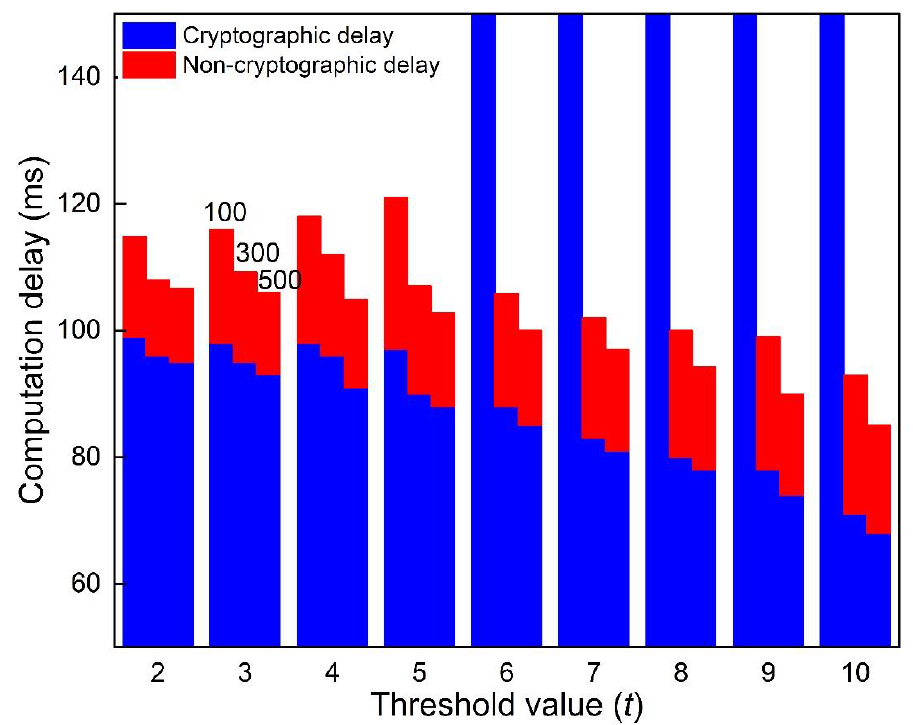
Figure 8. A comparison of cryptographic delay and non-cryptographic delay at various threshold values and number of vehicles (100, 300, 500).